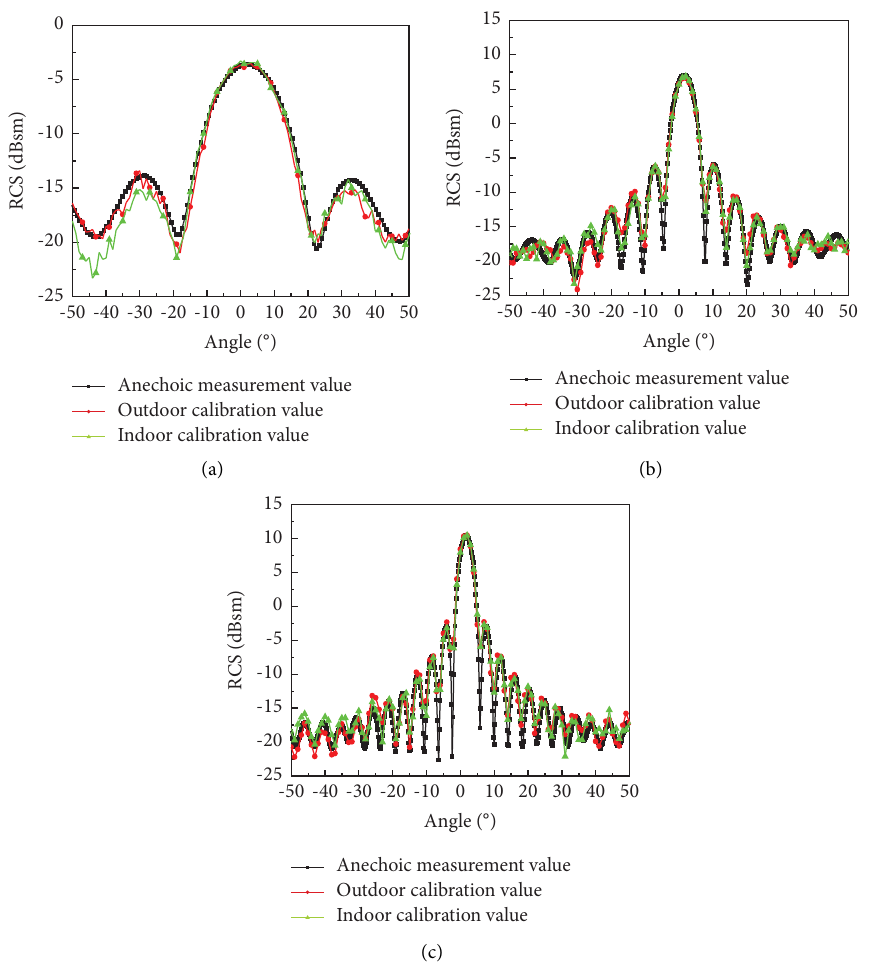
Figure 10: Graphite cube RCS measurement results. (a) Diferent angle RCS at 3GHz, (b) diferent angle RCS at 10GHz, (c) diferent angle RCS at